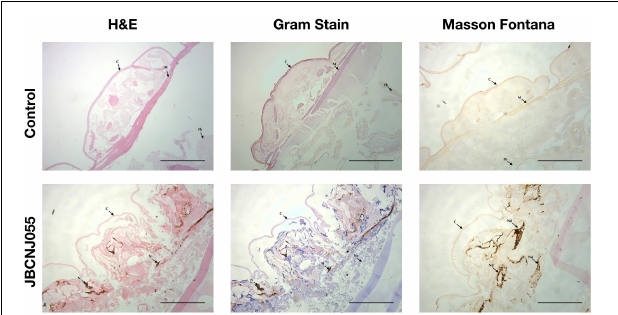
FIGURE 7 | Comparison of G. mellonella histopathology of control and infected groups after 72 h incubation after inoculation with 10 5 CFU of JBCNJ055. Sections were stained with H+E, Gram-stain and Masson Fontana (highlighting melanin deposition). Infected groups show distinct loss of tissue structure, systemic proliferation of Gram-positive bacteria and a large production of melanin within peripheral tissues indicative of systemic pathogenicity. Scale bars represent 1 mm. C, Cuticle; M, Muscle layer; N/Nd, Nodules; Fb, Fat body; Nc, Necrosis.